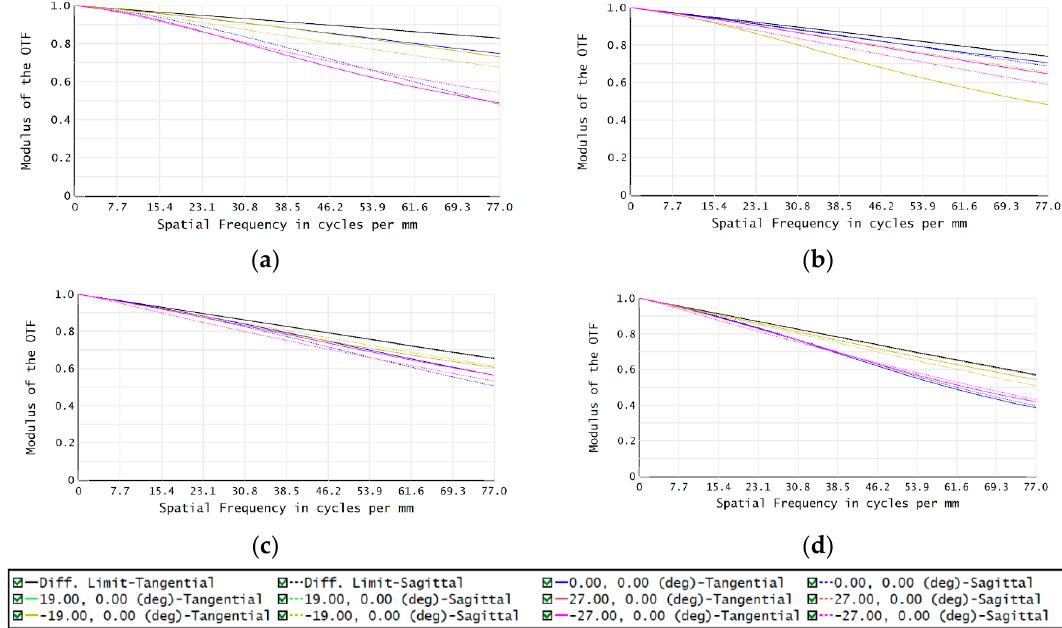
Figure 12. MTF of the integrated system ( a ) 400 nm; ( b ) 600 nm; ( c ) 800 nm; ( d ) 1000 nm.